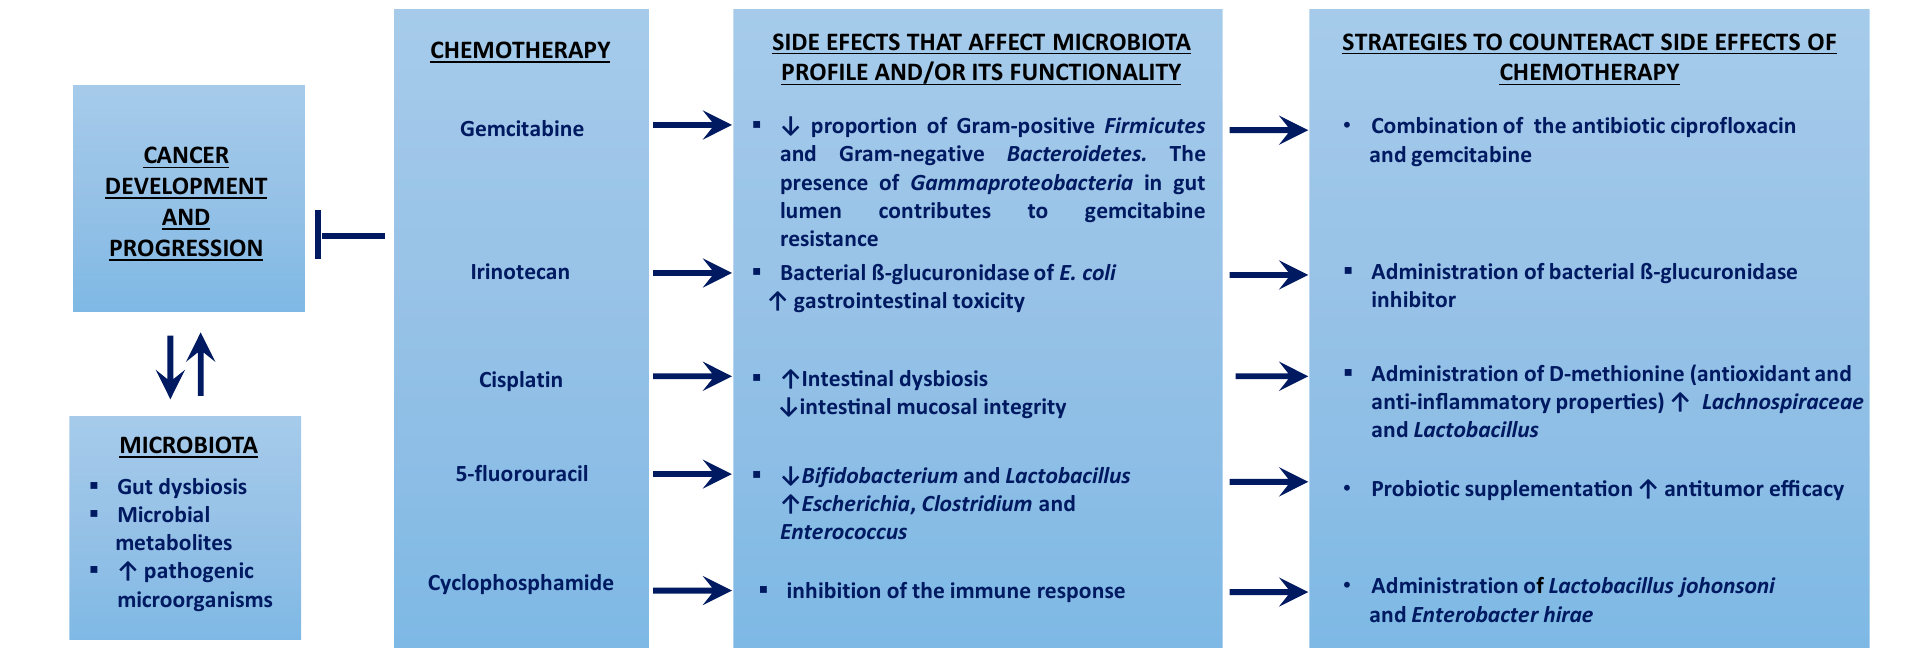
Figure 2. The gut microbiota affects cancer pathogenesis and the metabolism of chemotherapy drugs, conditioning both the response of cancer cells and the susceptibility of healthy cells. ↑ means increment; ↓ means decrease; ⱶ means inhibition.